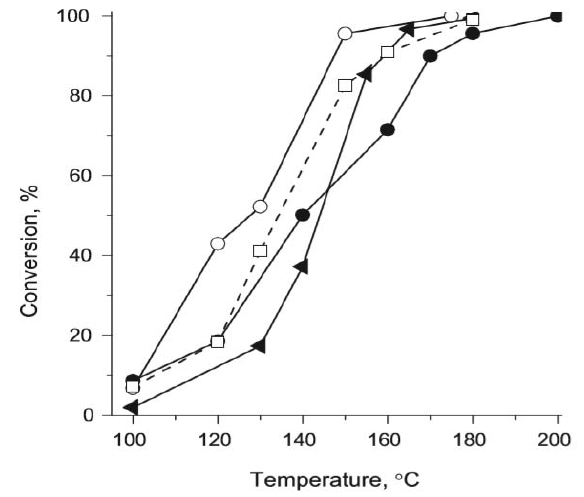
Figure 15. Temperature dependence of the formaldehyde conversion over the catalysts: ● , Ag/SiO 2 ; ○ , Ag/CeO 2 /SiO 2 ; ◄ , Ag/MnO x /SiO 2 ; □ , Ag/CeO 2 –MnO x /SiO 2 . Reaction conditions: 18,000–22,000 ppm of CH 2 O in dry air; catalyst mass 145 mg; WHSV = 69,000 mL/(gcath). Reproduced from [145] with permission from Elsevier.